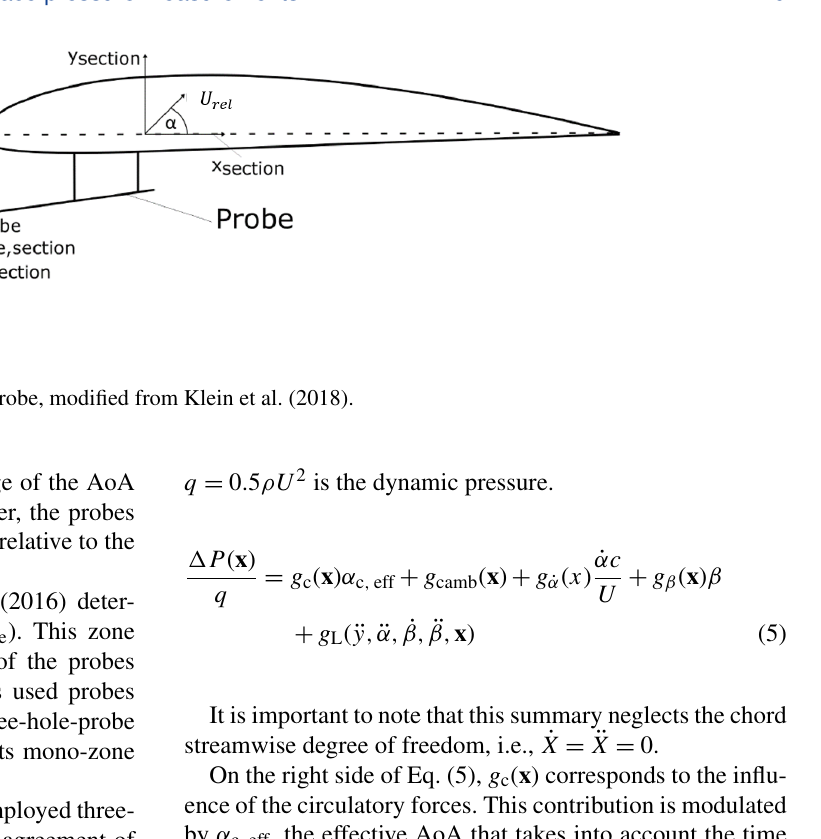
adding the corresponding twist angle, the range of the AoA relative to the probes is α probe ≤ 18 ◦ . Moreover, the probes are aligned with the chord; thus the yaw angle relative to the probe is the same − 30 ◦ ≤ ψ probe ≤ 0 ◦